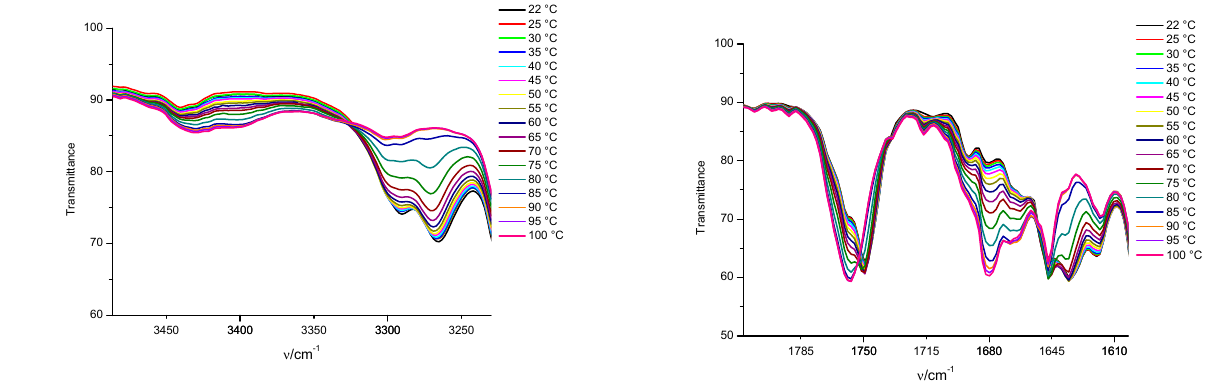
Figure 2. Upper plots: temperature-dependent FTIR spectra of 1a /toluene-d 8 (c = 0.23 M) and Lower plots: temperature-dependent FTIR spectra of 2a /toluene-d 8 (c = 4.2 × 10 − 2 M) gels in the temperature range of 20 (22)–100 °C.